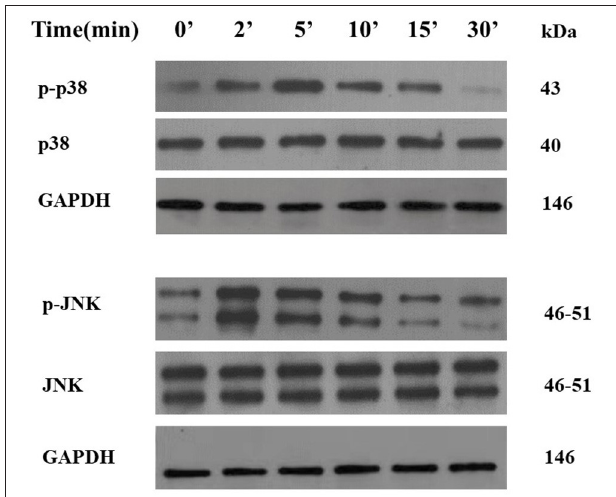
FIGURE 8 | Activation of p38 and JNK pathways by IL-18 in rat VSMCs. After using IL-18 to interfere with rat VSMCs for 2, 5, 10, 15, and 30, the phosphorylation and non-phosphorylation protein expression levels of two MAPK pathways including p38 and JNK were detected by Western blot. The experiment was repeated 3 times